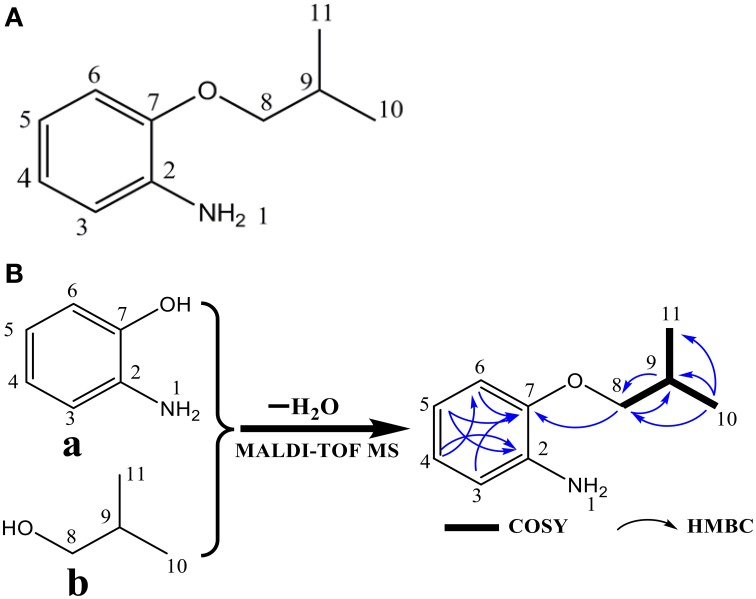
Structure (A) and the fragments, key COSY, and HMBC correlations (B) of the (2-isobutoxyphenyl)amine algicidal compound. In (B), fragment a is 2-aminophenol, and fragment b is the 2-methylpropan-1-ol terminal residue.